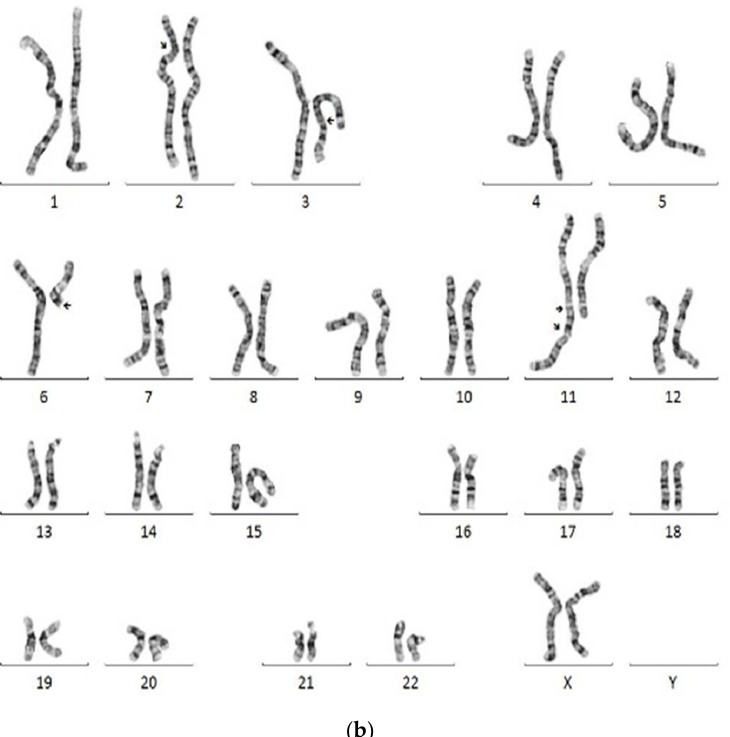
Figure 2. Cytogenetic characterization of the cultured blood lymphocytes. Conventional G-banding analysis of cultured blood lymphocytes showed a complex karyotype: 46,XY,der(2)t(2;6)(p16;q21), der(3)t(2;3)(p16;q21),del(6)(q13),der(11)ins(11;6)(q25;q13q21)t(3;11)(q21;q25) in the child ( a ). A similar complex GTW-banding pattern was seen in the mother ( b ). The der(11) chromosome marked with two breakpoints that probably derived from insertion of 6q13 6q21 into band 11q25, and translocation of the segment 3q25 3qter to chromosome 11 at band 11q25. Cytogenetic nomenclature is based on ISCN 2020. The arrows indicate breakpoints.